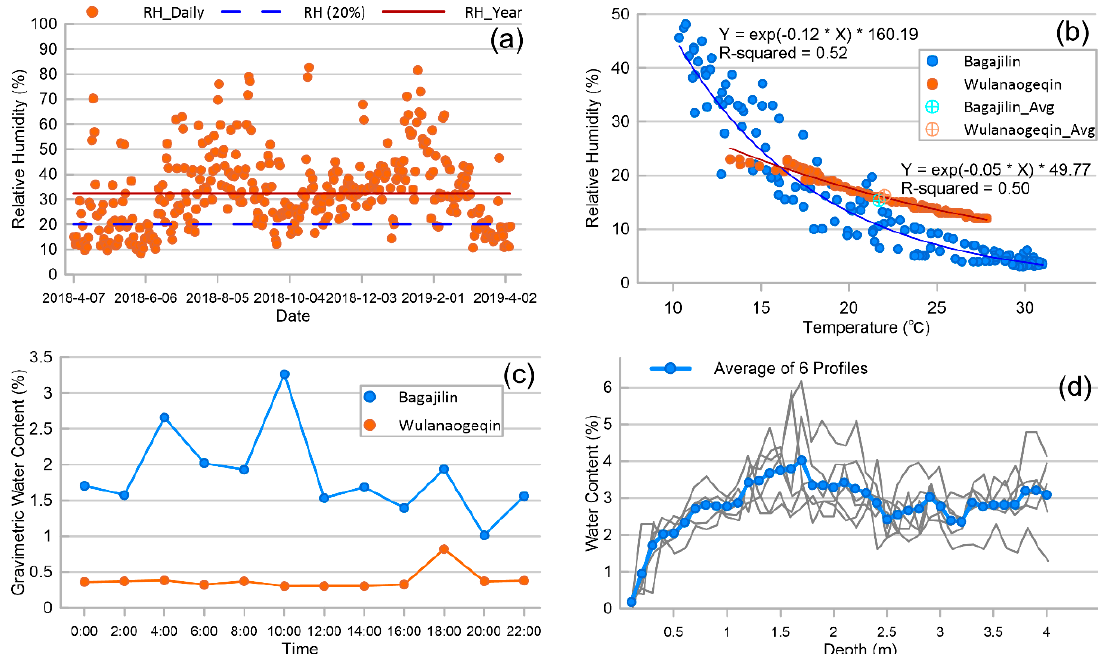
Figure 7. ( a ) Relative humidity from the automatic weather station of Sumubarunjilin (Figure 1b) from 7 April 2018, to 6 April 2019. Solid line is the average (32.4%). Dashed line represents the minimum relative humidity (20%) when water vapor adsorption occurs [30]. ( b ) Scatter plot showing the relationship between air temperature and relative humidity in the lake basin (Bagajilin) and non-lake basin (Wulanaogeqin), and their average values and exponential fittings. The linear distance of the two observation sites was approximately 3.2 km. ( c ) Variation of gravimetric water content of the surface sand layer in the lake basin and non-lake basin over 24 h. Data were recorded in China Standard Time, which is approximately 1 h 10 min before Local Time. ( d ) Water content of six profiles with depths of 4 m on the leeward slope of a dune in the lake group area, and their average [38].